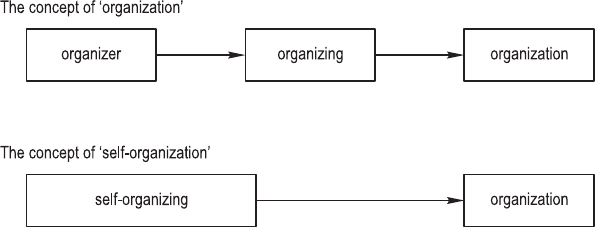
Fig 1. Disentanglement of the concepts of ‘organization’ and ‘self-organization’